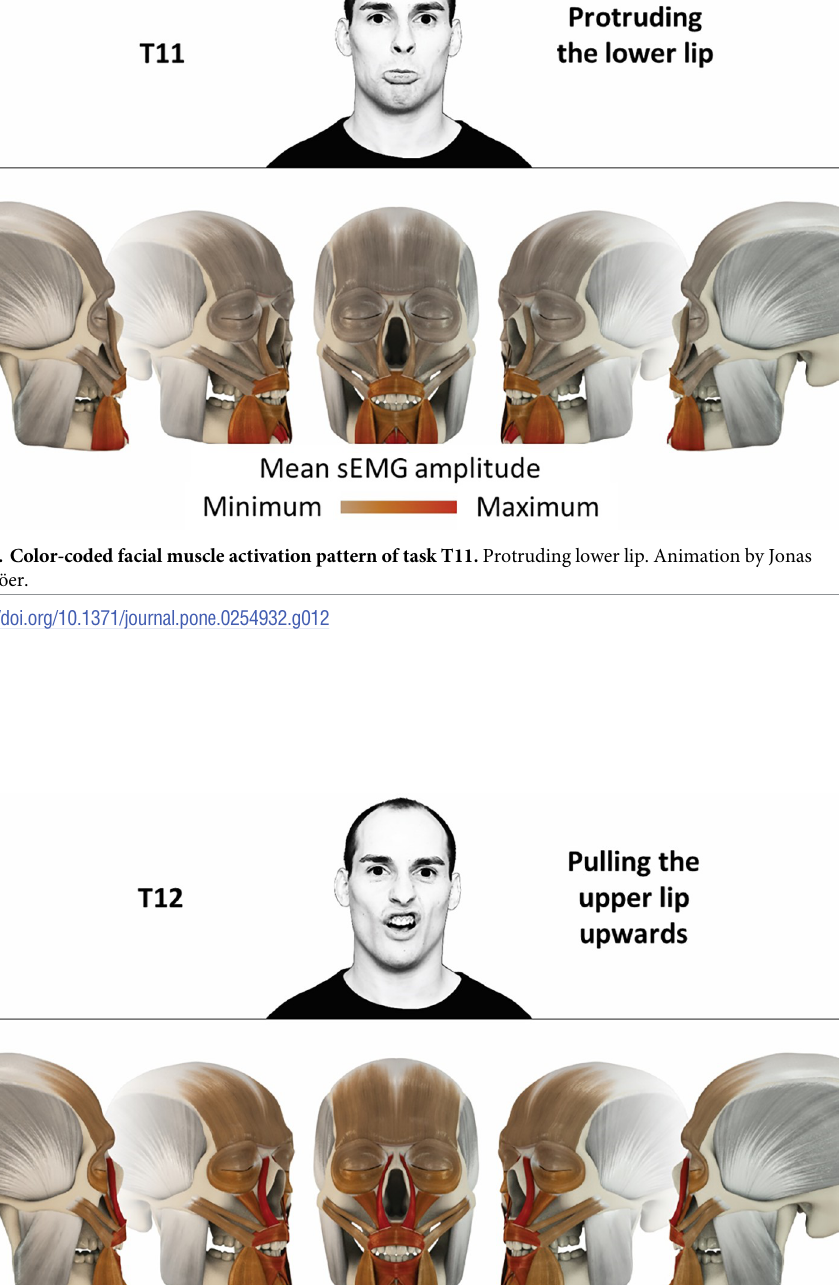
PLOS ONE | https://doi.org/10.1371/journal.pone.0254932 July 19,